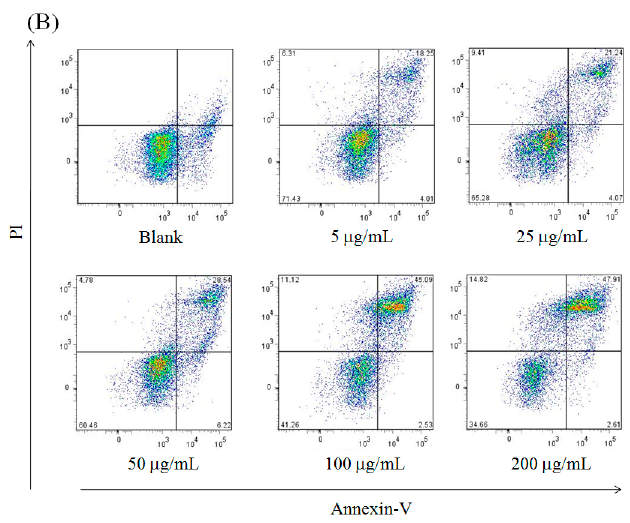
Figure 1. The anti-ovarian carcinoma cells activity of AEPP in OVCAR-3 cells by ( A ) cell viability and ( B ) apoptosis/necrosis measurements. Data were shown as mean ± SD ( n = 3). A significant difference is shown by different letters between groups ( p < 0.05). Table 1. Effects of AEPP on apoptosis induction in OVCAR-3 cells.